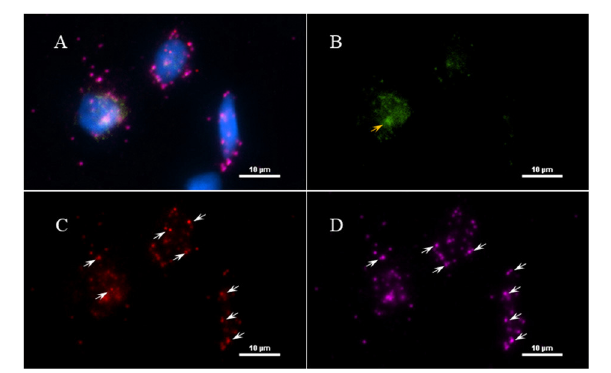
FIGURE 8 | Validation of RNA integrity on Fresh frozen NHP (MJ 61) frontal cortex brain tissue using RNAscope assay. NHP tissue was stained with a 3-plex positive control probe POLR2A targeting DNA-directed RNA polymerase II RPB1, PPIB targeting cyclophilin B, and UBC that targets